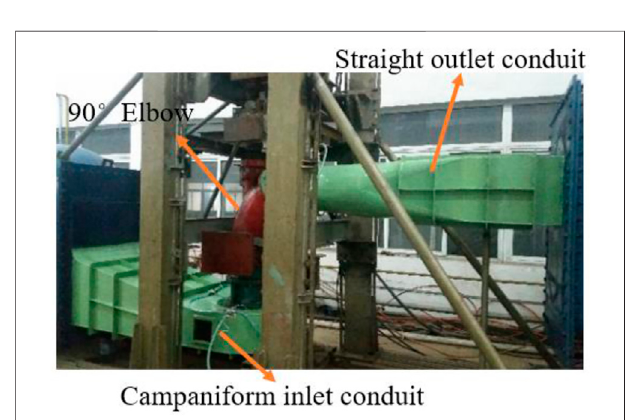
FIGURE 4 | Pump device test